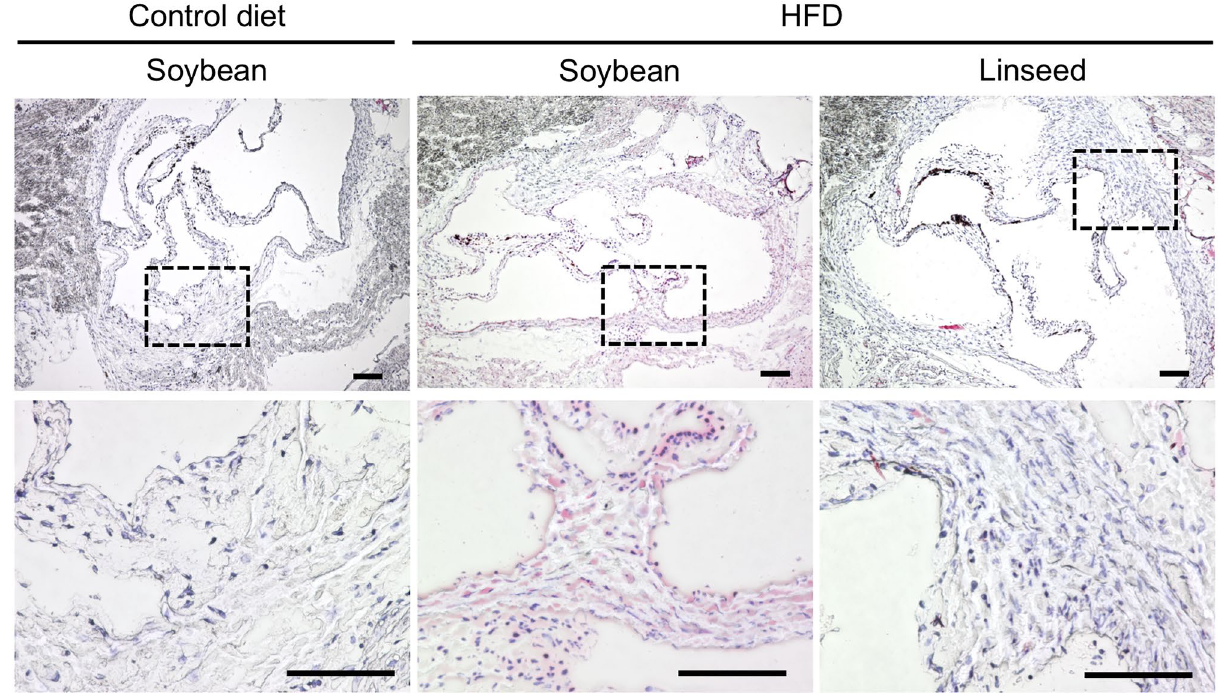
Figure 2. HFD-induced tissue deposition of lipid was inhibited by dietary linseed oil. Mice were fed with either control diet with soybean oil, HFD with soybean oil or HFD with linseed oil for 10 months, and histological sections of aortic valve were examined by staining with oil red O solution. Upper row shows pictures with low magnification. Lower tier shows pictures with high magnification of indicated square areas. Data are representative of 2 independent experiments (n = 5/group/experiment). Scale bars 100